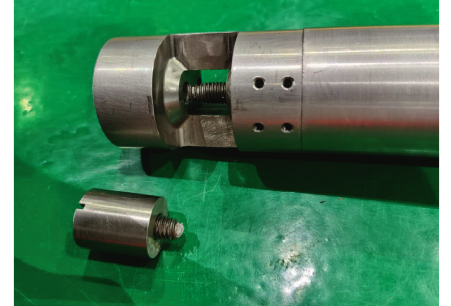
Figure 6: The broken sample.